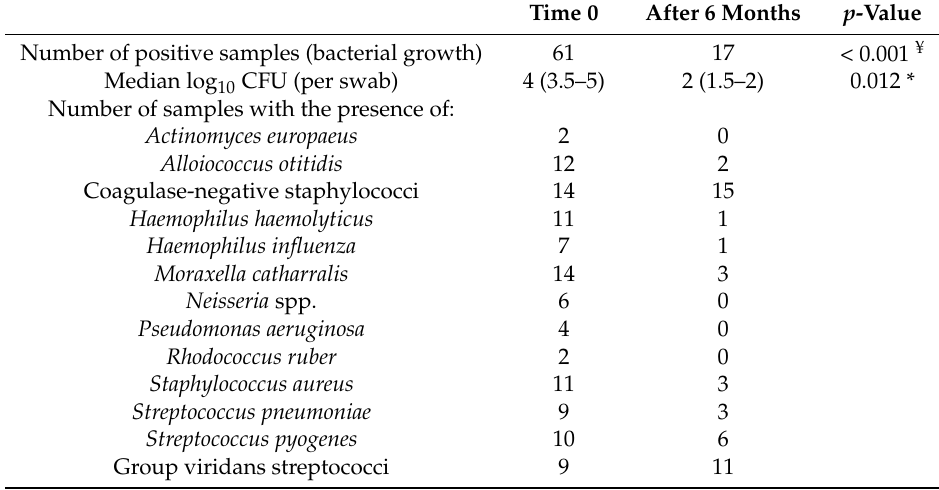
Table 5. Results of the microbiological analysis of the samples from the external auditory canal taken at day 0 before the probiotic intervention and at the end of the 6-month treatment period. Time 0 After 6 Months p -Value Number of positive samples (bacterial growth) 61 17 < 0.001 ¥ Median log 10 CFU (per swab) 4 (3.5–5) 2 (1.5–2) 0.012 * Number of samples with the presence of: Actinomyces europaeus 2 0 Alloiococcus otitidis 12 2 Coagulase-negative staphylococci 14 15 Haemophilus haemolyticus 11 1 Haemophilus influenza 7 1 Moraxella catharralis 14 3 Neisseria spp. 6 0 Pseudomonas aeruginosa 4 0 Rhodococcus ruber 2 0 Staphylococcus aureus 11 3 Streptococcus pneumoniae 9 3 Streptococcus pyogenes 10 6 Group viridans streptococci 9 11 ¥ Chi-squared test. * Wilcoxon rank sum